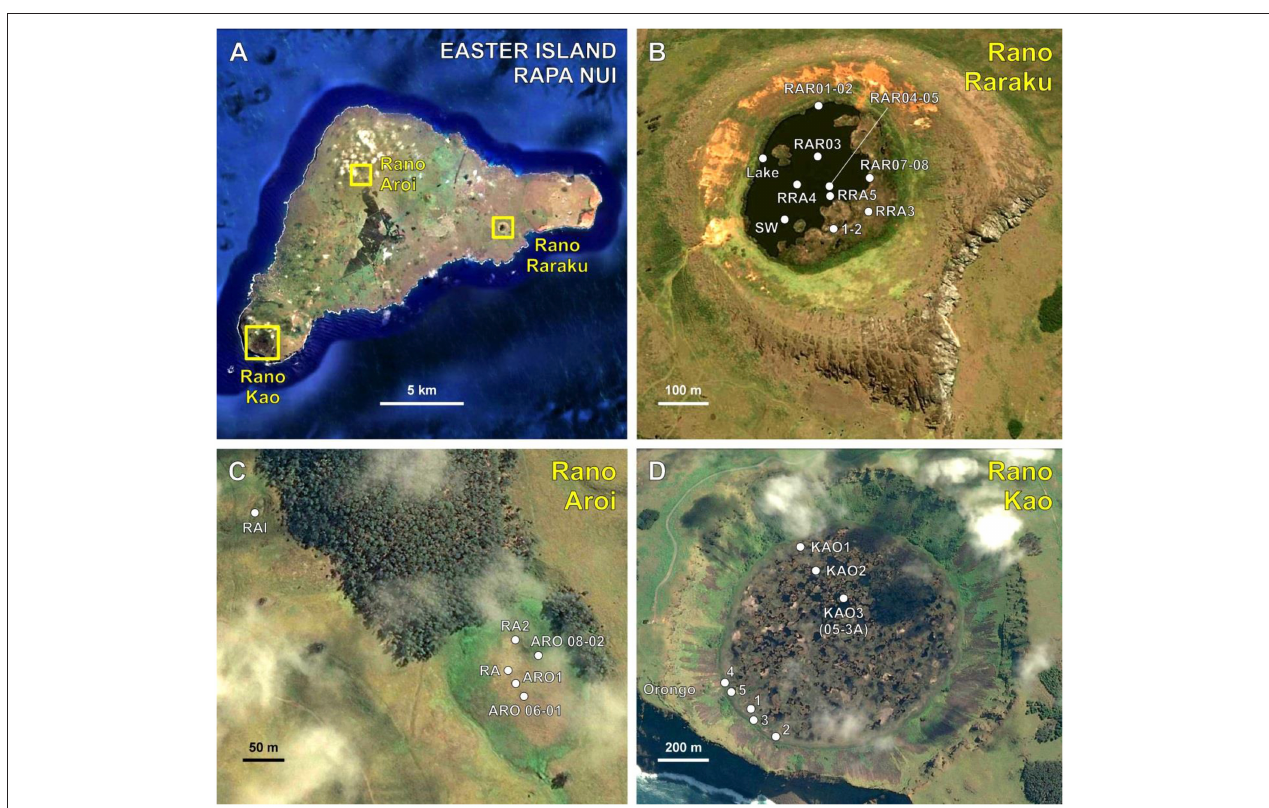
FIGURE 1 | Google Earth images of the lakes and mire studied, indicating the location of the cores from which radiocarbon ages originate. (A) Location of the lakes/mires, (B) Lake Raraku, (C) Aroi mire, (D) Lake